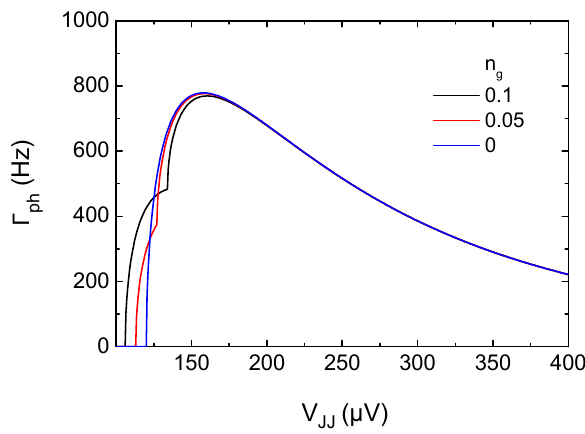
Figure 10. The rate Γ ph of photon-assisted generation of quasiparticles in the superconducting island calculated as a function of mean voltage across the Josephson source, for three slightly different gate settings around the even state n g = 0. For the parameters of the circuit used in the calculation, see Tables 1 and